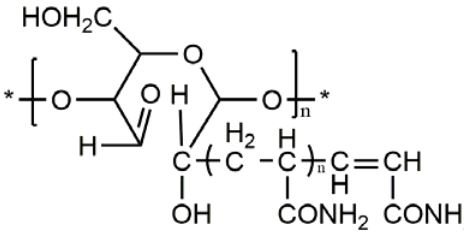
Figure 3. Molecular structure of GCF.